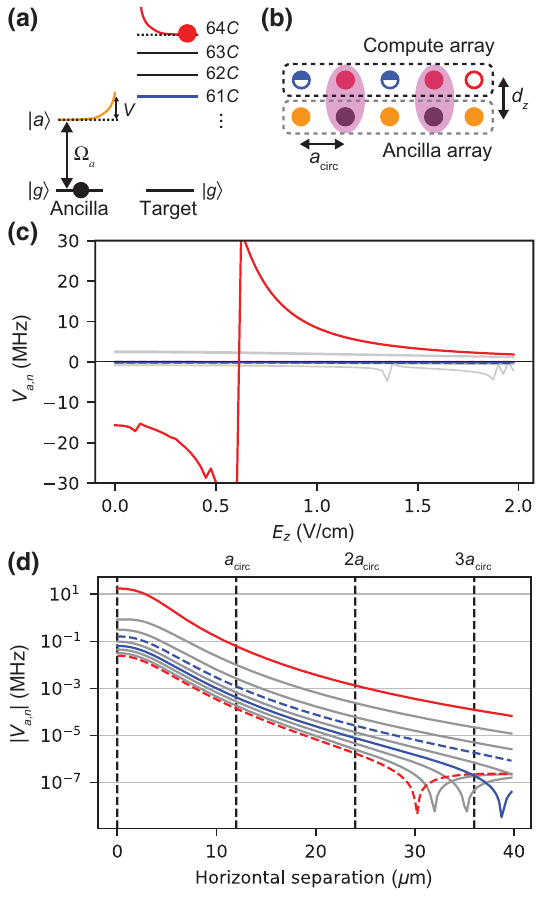
( µ m) FIG. 4. Nondestructive circular state detection. (a) The mea- surement is realized by a state-selective Förster resonance between a Rb ancilla in | a (cid:3) = 55 S and | 64 C (cid:3) . (b) An array of ancilla atoms displaced by d z = 5 μ m is used to probe the state of the circular atom array. The excitation to | a (cid:3) is blockaded on sites with a compute atom in | 1 a (cid:3) . (c) Van der Waals interaction V a , n between | a (cid:3) and | nC (cid:3) , as a function of electric field E z . The states n = 56–66 are shown, with the noncomputational states in